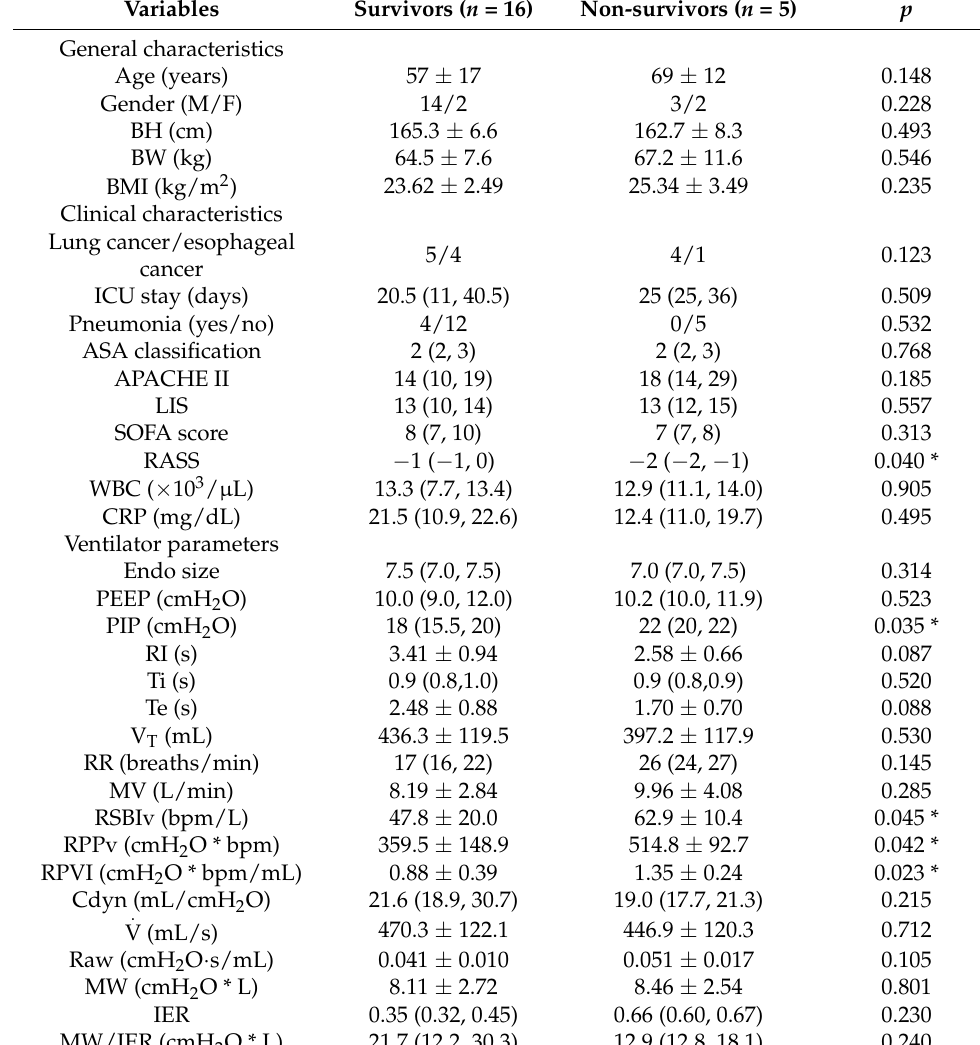
Table 2. Comparisons between surviving and non-surviving patients with